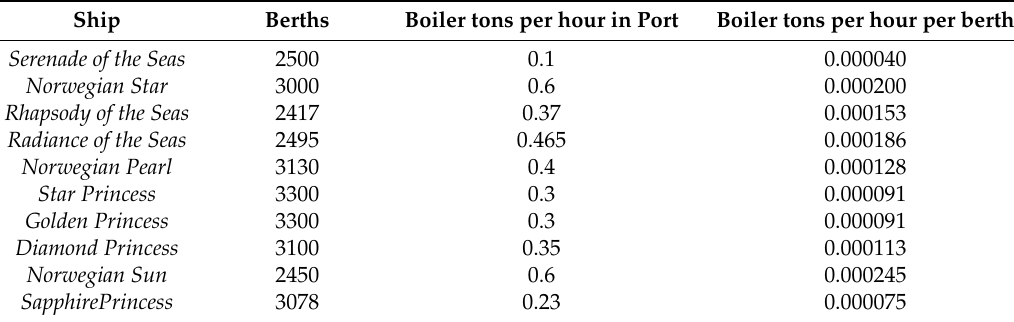
Table 4. Data for boiler consumption, tons per hour per